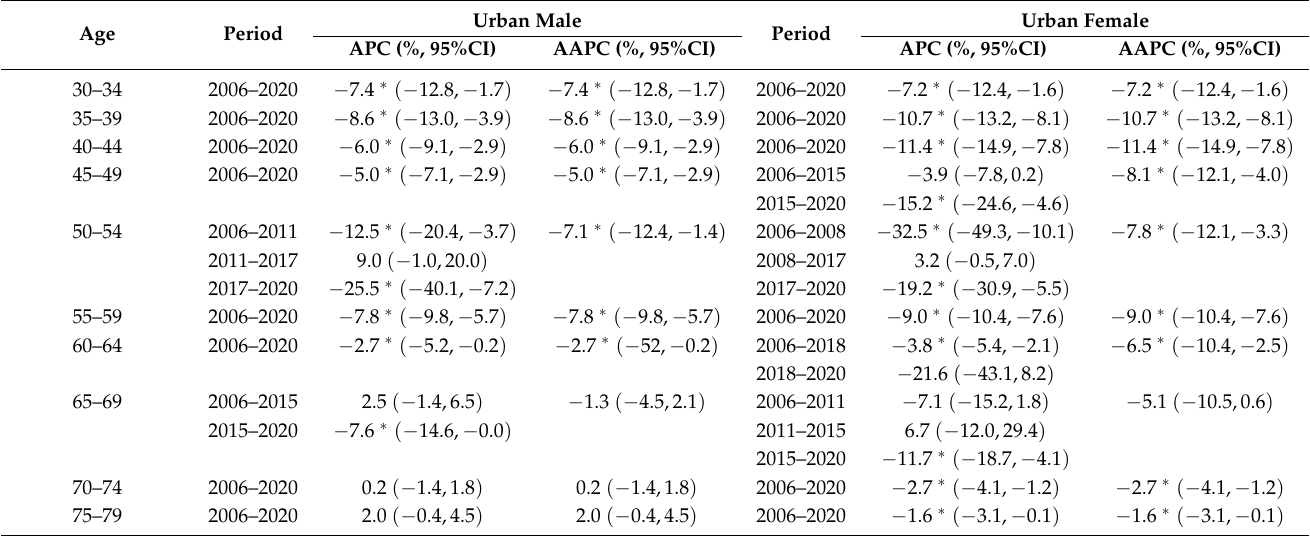
Table 3. Temporal trend analysis of age–specific mortality rates for RHD in urban Chinese residents